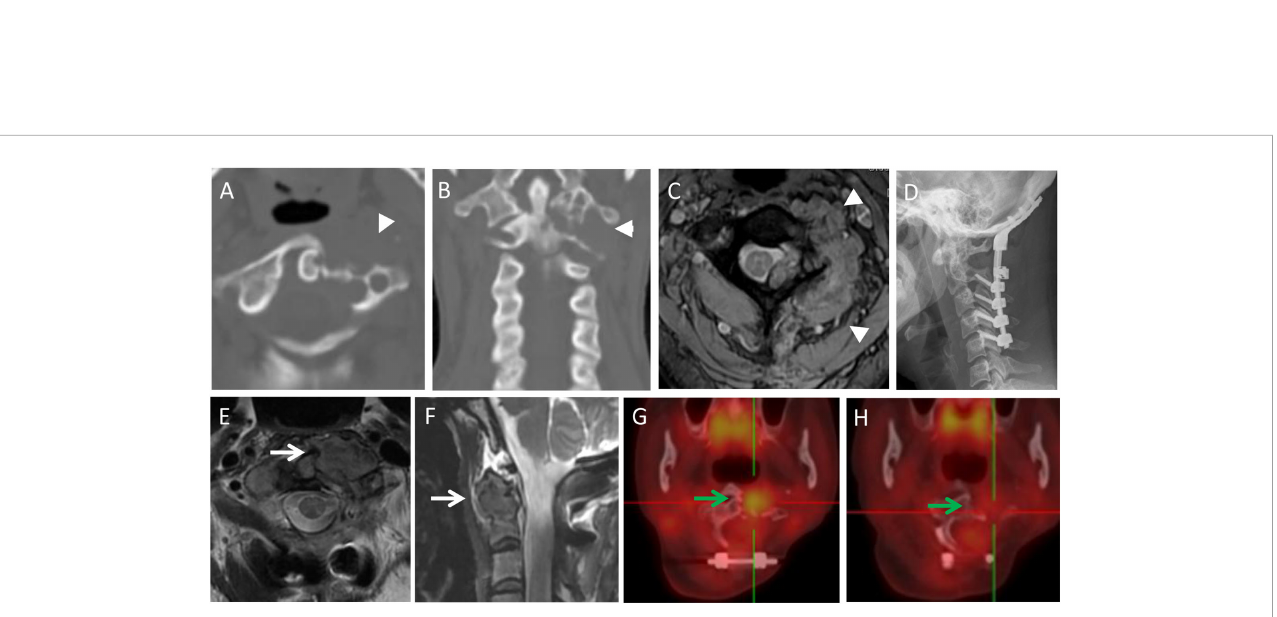
FIGURE 3 A 44-year-old female with neck pain for fi ve months, an osteolytic lesion was located in the C1-2 (arrowheads). She underwent STR because of vertebral artery invasion. In 6th month follow-up, the MRI scans revealed the local recurrence with a soft tissue mass (white arrows). She underwent radiotherapy but refused further operation. In the subsequent 96 months follow-up, the lesion was stable and repeated PET-CT revealed the reduced uptake of the lesion (green arrows). (A,B) : Preoperative axial and coronal CT scans; (C): Multiecho gradient-echo sequence axial MRI scan; (D) : Postoperative X-ray; (E,F) : T2-weighted axial and sagittal MRI scans in 6th month follow-up; (G) : PET-CT in 18-month follow-up after radiotherapy (SUV max 6.0); (H) : PET- CT in the 90-month follow-up after radiotherapy (SUV max